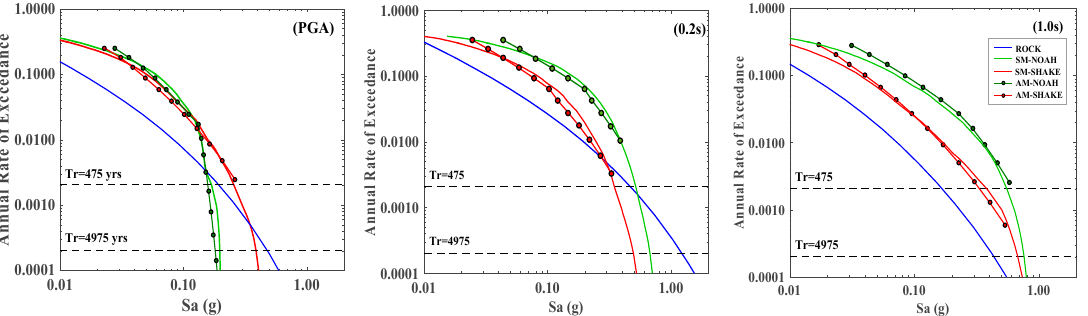
Figure 20. Hazard curves on hard rock (blue) and soil using the equivalent-linear SHAKE91 simulations (red) and nonlinear NOAH simulations (green) for both AM (points) and SM (solid line) methods, at three different spectral periods (PGA, 0.2 s and 1.0 s).